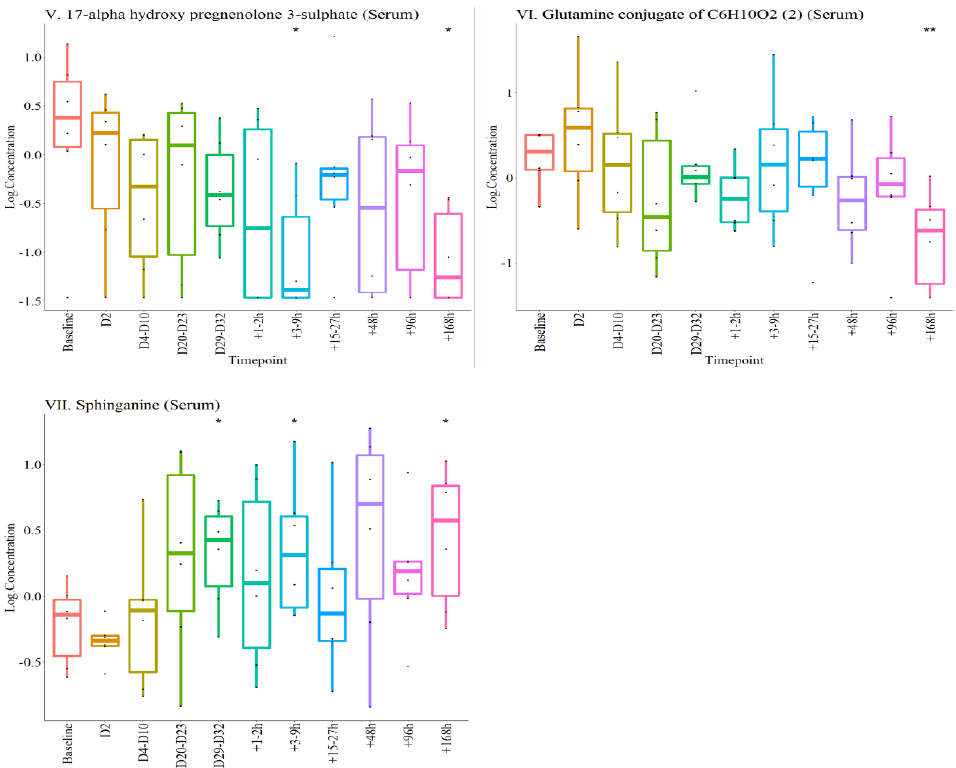
Figure 7. Serum concentrations of 7 metabolites altered at different time points during the experi- ments. The log concentrations at different time-points are plotted for each metabolite as labelled in I to VII. * p < 0.05, ** p < 0.01, compared with baseline.